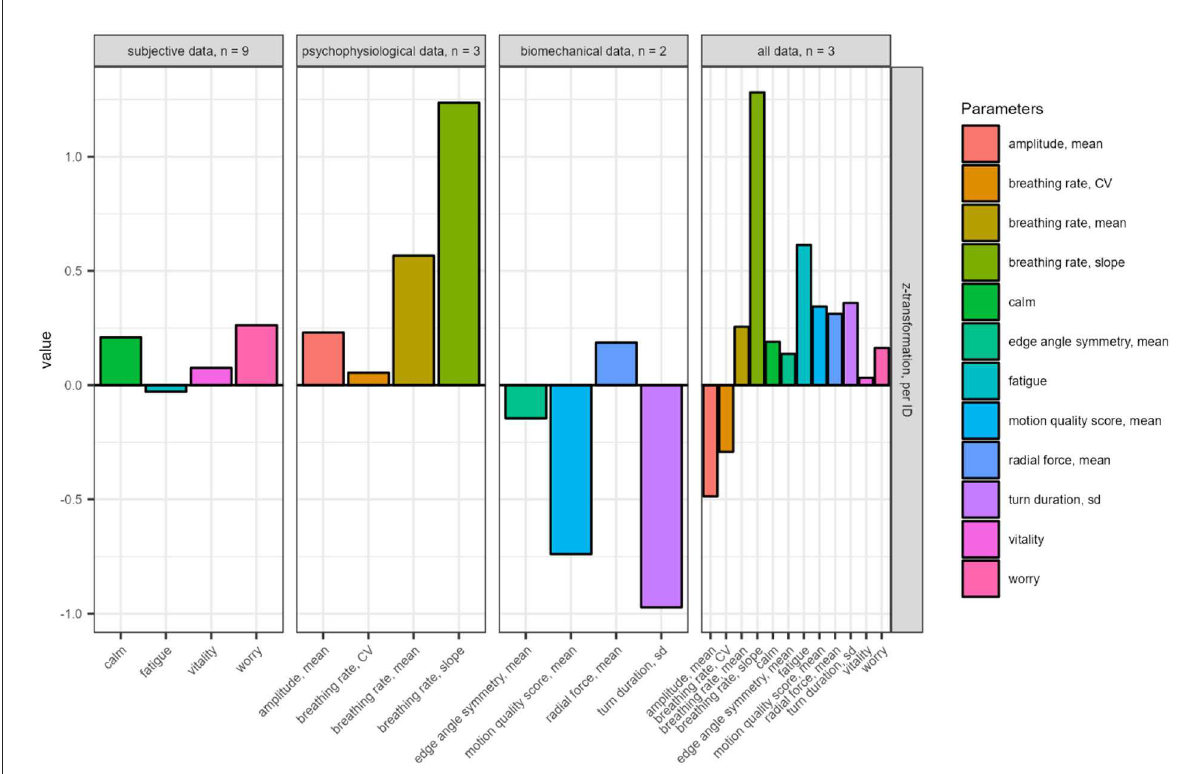
FIGURE6 Mean absolute changes of the z-transformed parameters at the change